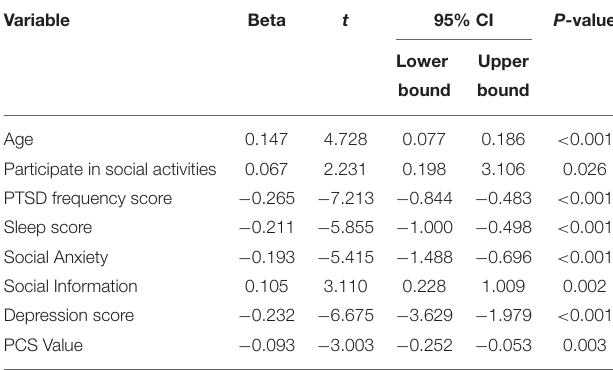
TABLE 3 | Multiple linear regression for possible related factors of PCS value of SF-12. Variable